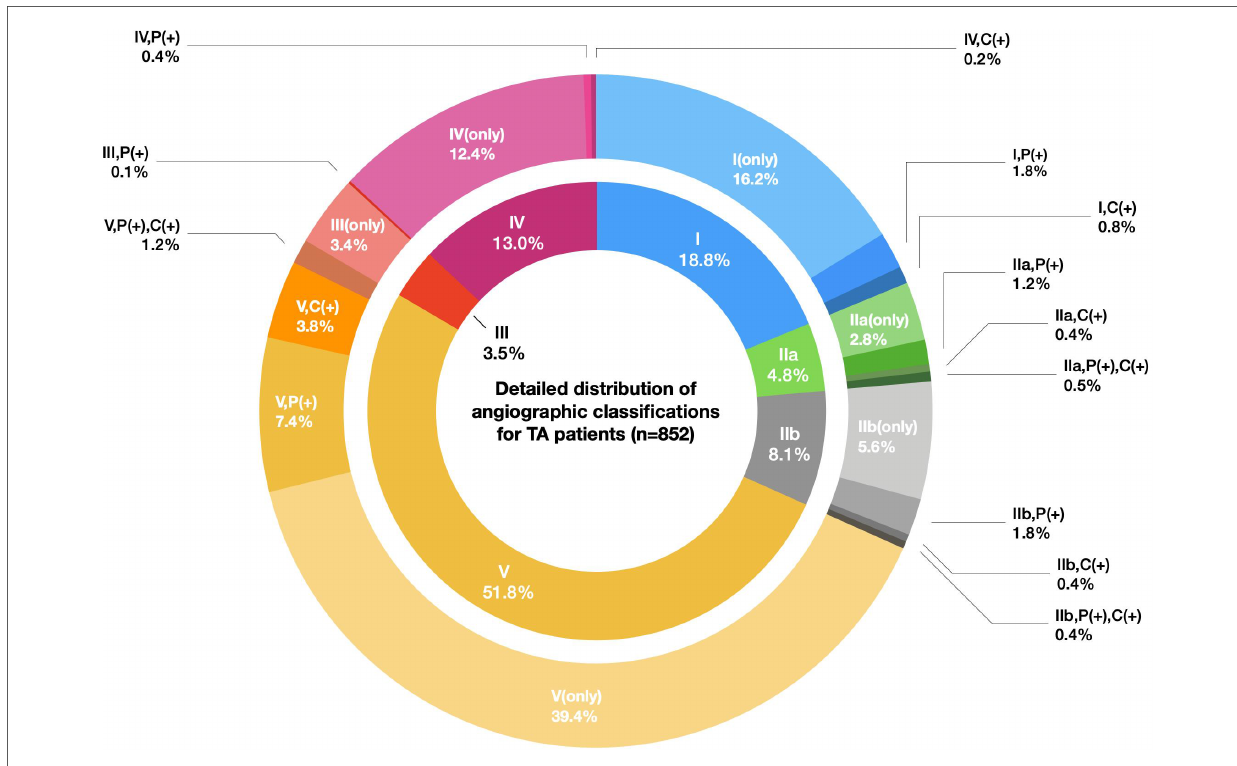
FIGURE 2 Detailed distribution of the angiographic classi fi cations for TA patients ( n =852). Legend: The inner circle indicates the proportions of six Numano angiographic patterns I – V, and the outer circle represents the detailed proportions of the Numano angiographic patterns I – V plus the involvement of the pulmonary artery or coronary artery. The fragments with the same color scheme in the inner and outer circles belong to a speci fi c type of Numano angiographic pattern I –